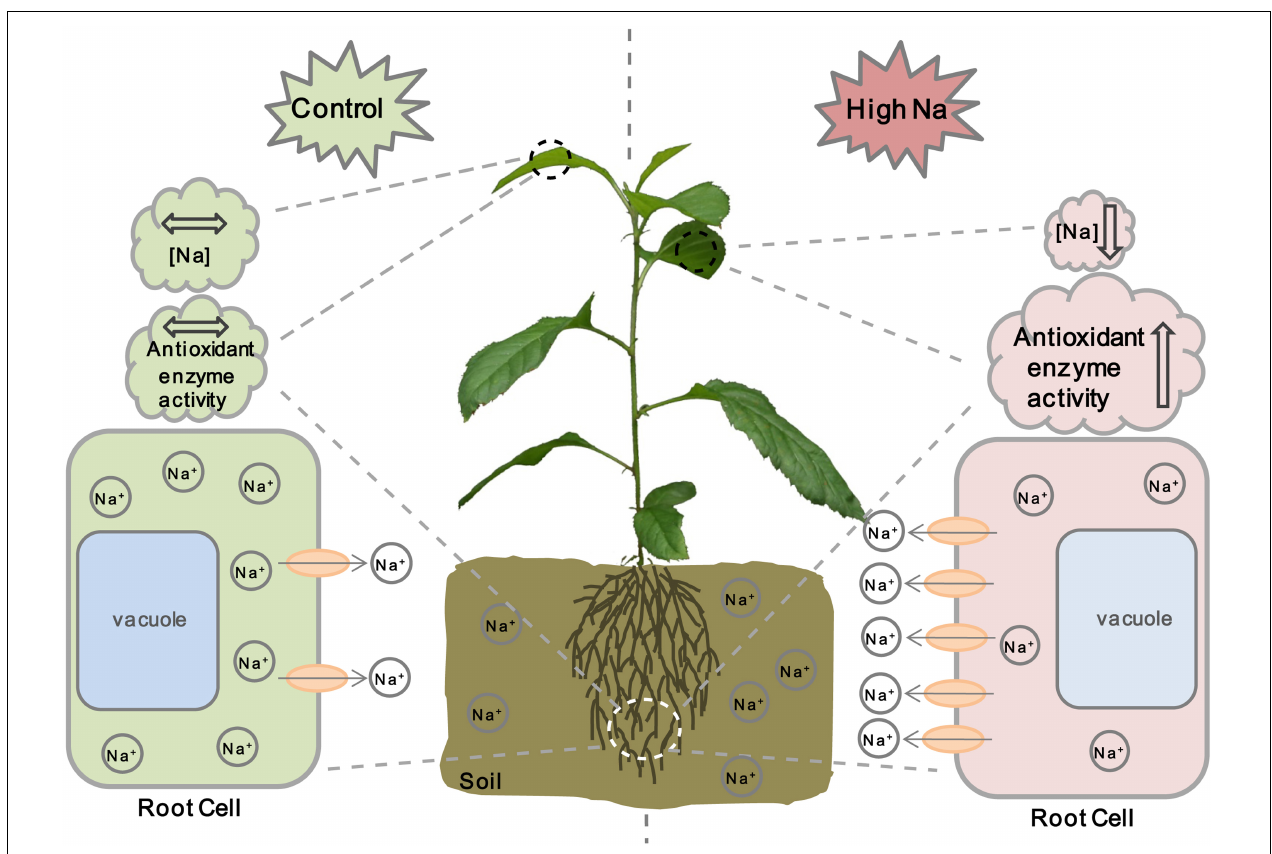
FIGURE 10 | A working model illustrating MdCCX1-mediated salt response in apple plants. Under normal conditions, the expression level of MdCCX1 is maintained at a basal level to maintain ion homeostasis and normal plant growth and development. Under salt stress, the MdCCX1 expression is induced, and the MdCCX1 protein accumulates in roots of apple plants. The accumulated MdCCX1 protein inhibits the accumulation of Na + in roots by expelling excess Na + into the extracellular space or rhizosphere environment. This function of MdCCX1 may also facilitate the transport and dispersion of Na + to other tissues. Moreover, with the continues of salt stress, the increase of Na + content induces MdCCX1 accumulation in both roots and leaves, and the accumulated MdCCX1 in turn promotes the activity of antioxidant enzymes to scavenge ROS. The ovals represent the MdCCX1 transporters, and the arrows represents the direction of Na + transport across the cell